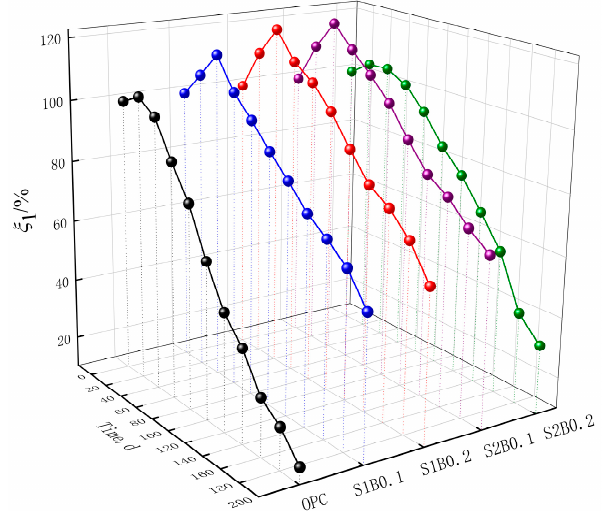
Figure 3. Time variation curve of compressive strength evaluation parameters.